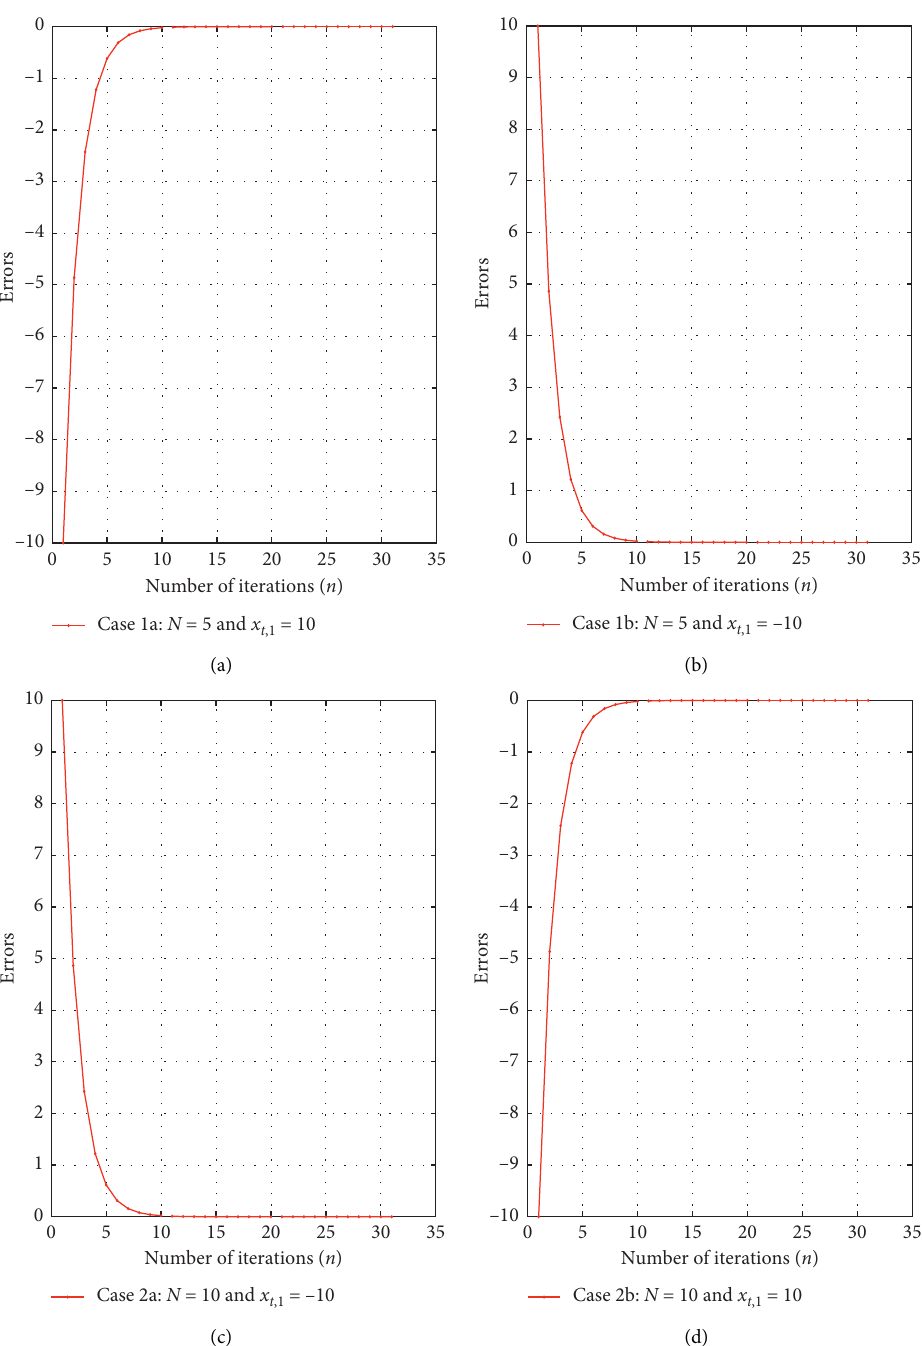
Figure 1: Errors vs. iteration numbers ( n ): case 1a (a); case 1b (b); case 2a (c); case 2b